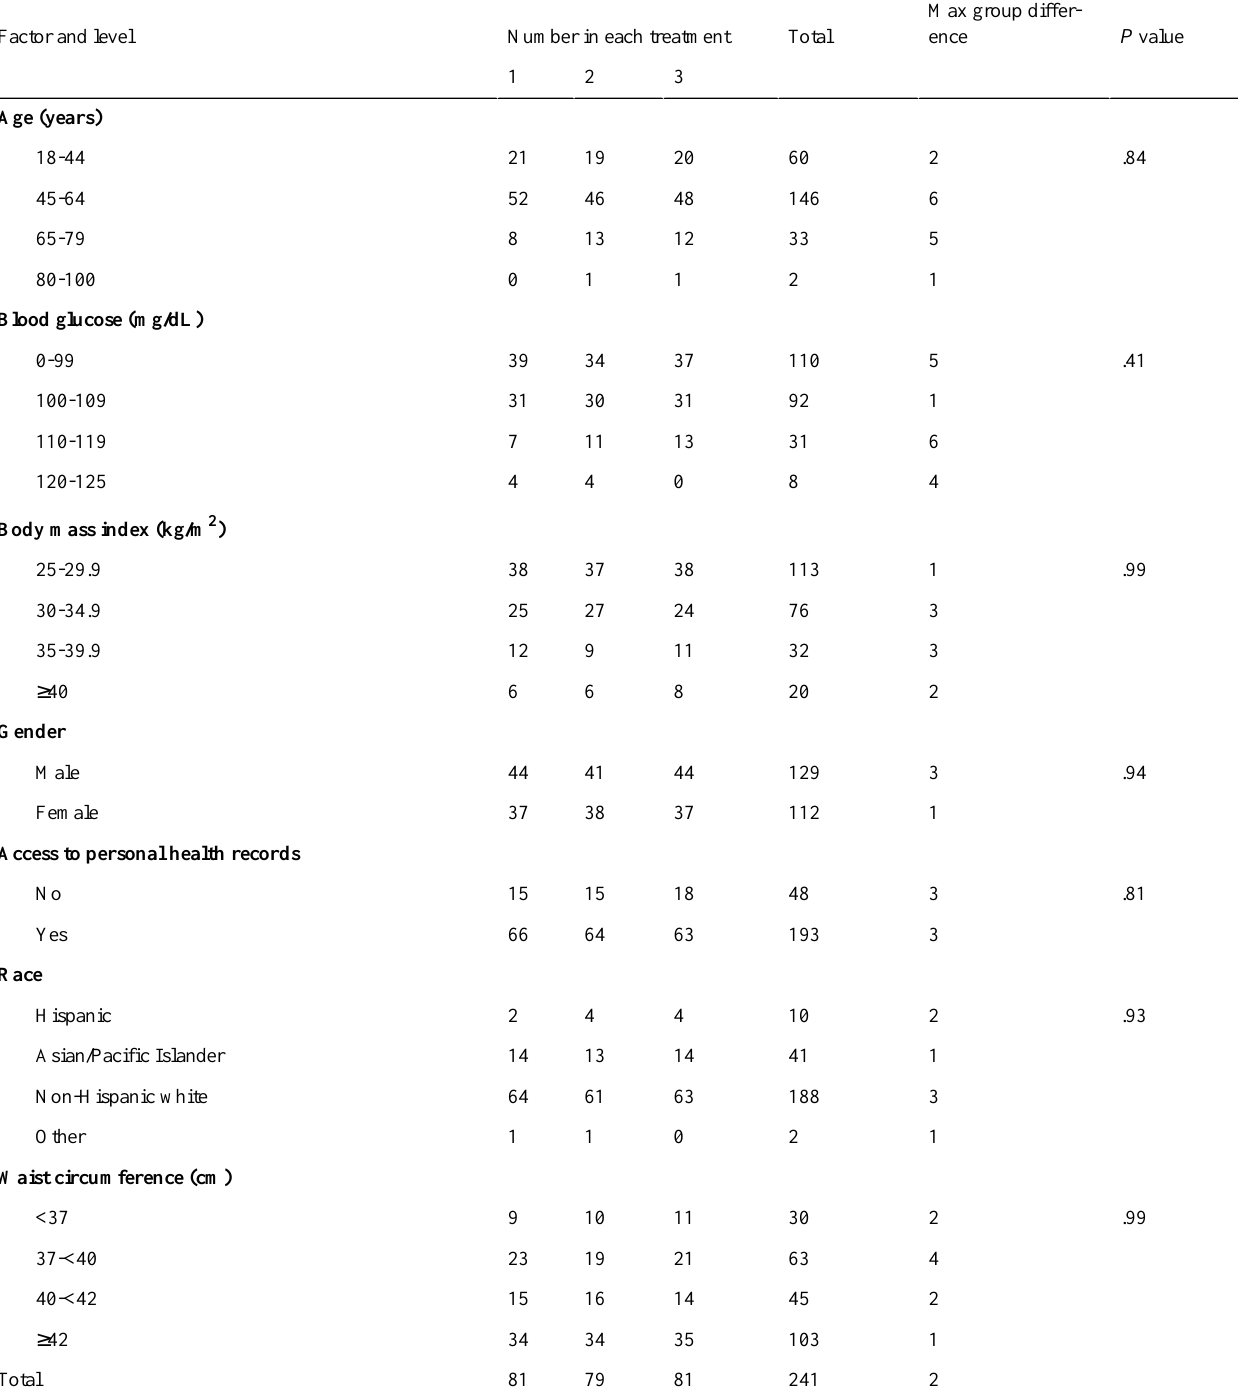
Table 1. Between-group differences in prognostic factors for the Evaluation of Lifestyle Interventions to Treat Elevated Cardiometabolic Risk in Primary Care (E-LITE)